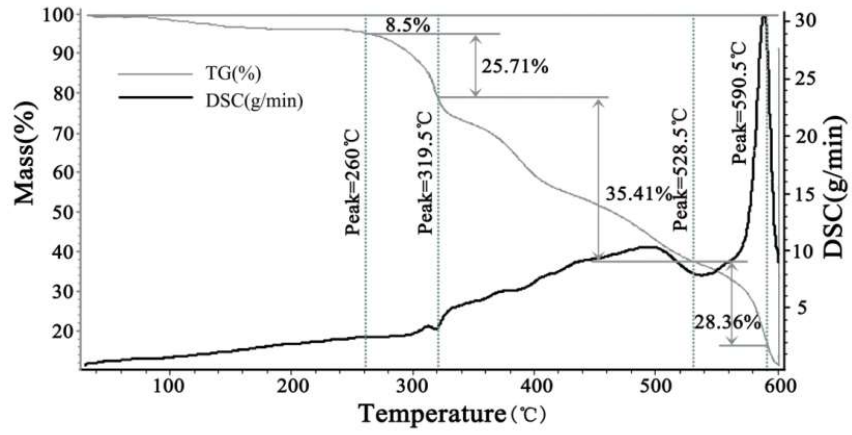
Figure 4. TG- DSC curve.